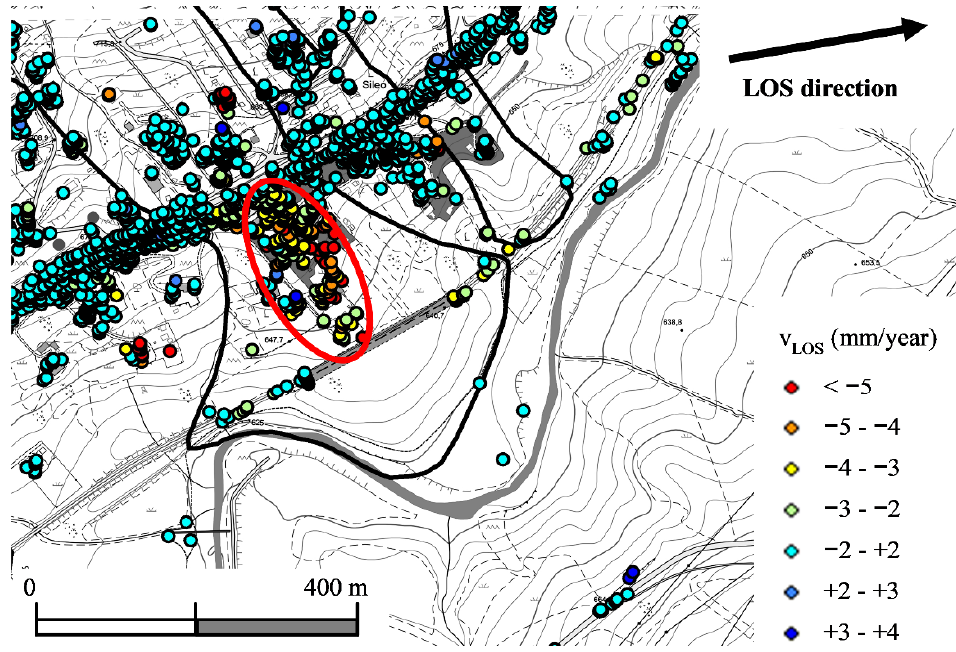
Figure 4. Average displacement rates in the period May 2011 – March 2014 evaluated from COSMO- SkyMed ascending data for the accumulation of Varco d’Izzo earthflow (redrawn from [29]).